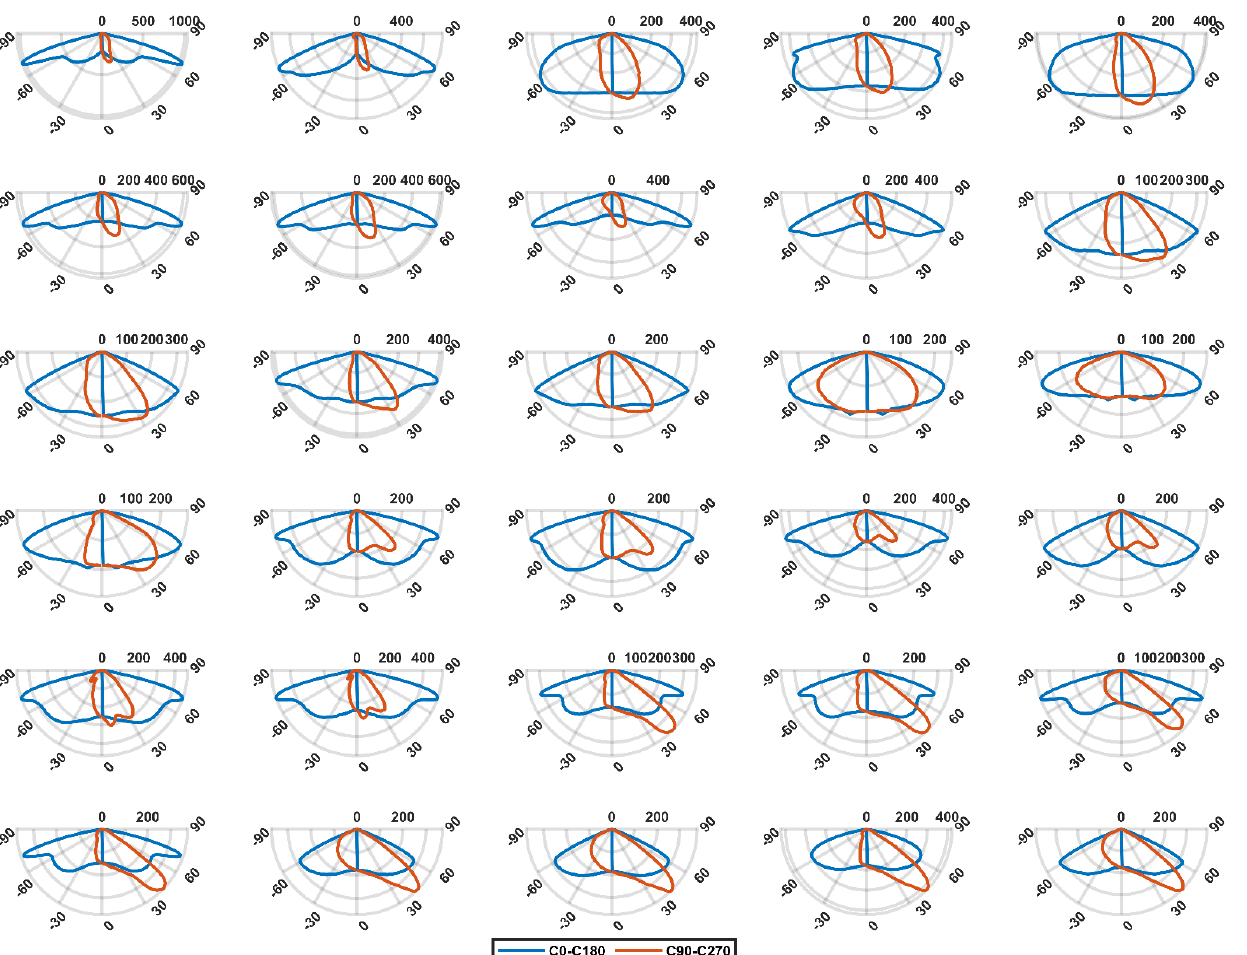
Table 1. Road lighting calculation parameters used in ReluxDesktop.